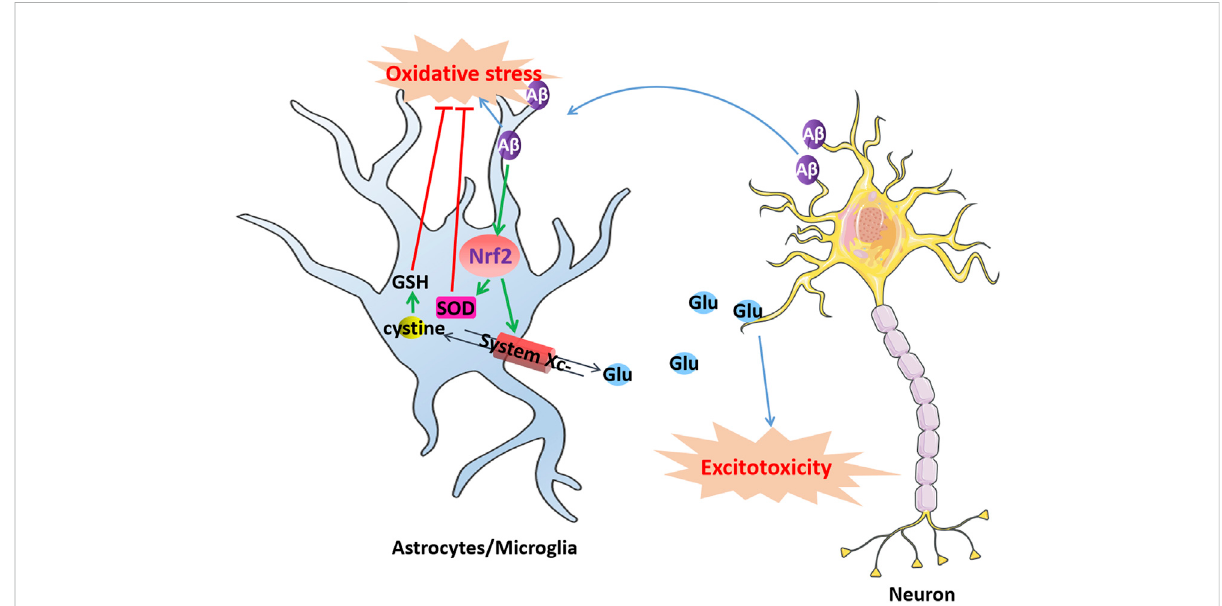
FIGURE 2 DysfunctionofsystemXc-induceexcitotoxic neuronaldegenerationinAD.A β producedbyneuronsaggregatesextracellularlytoformtoxic A β aggregates causes oxidative stress in microglia or astrocytes, which activates Nrf2 and produces SOD to resist oxidative stress. The activation of Nrf2also canupregulatesystem Xc-toresistoxidativestressinducedbyA β whilesimultaneouslyreleasing glutamate.However,excessivelyreleased glutamate can cause excitotoxicity in neurons, leading to cell